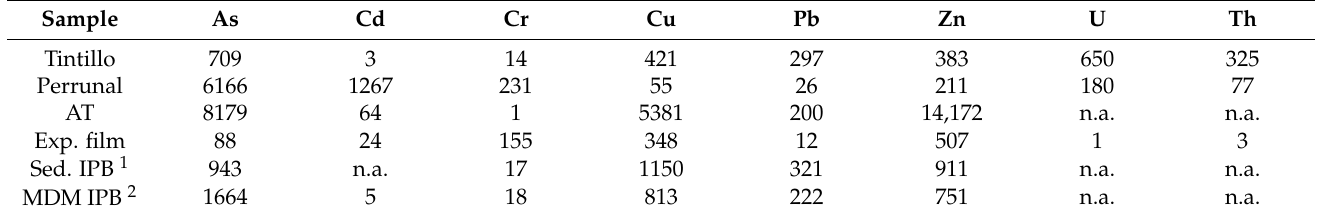
Table 3. Trace element concentrations (given in ppm and measured with ICP-MS and/or ICP-AES) of iron-rich floating mineral films found in stagnant mine waters of the IPB (Figures 2–5). All values refer to single measurements conducted on representative samples from each